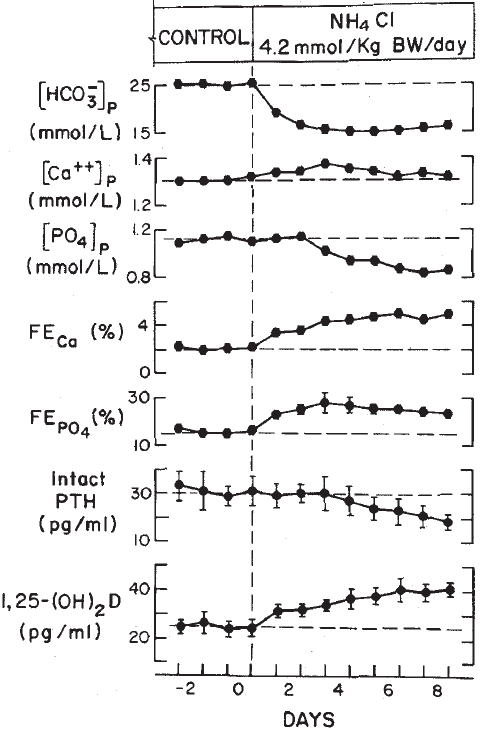
Figure 2 Effect of metabolic acidosis (induced by NH 4 Cl ingestion) on bicarbonate, plasma ionised calcium and plasma phosphate concentrations, the fractional excretion rates of calcium and phosphate as well as intact PTH and 1,25-(OH) 2 vitamin D levels ([24], with per- mission, The Journal of Clinical Investiga-